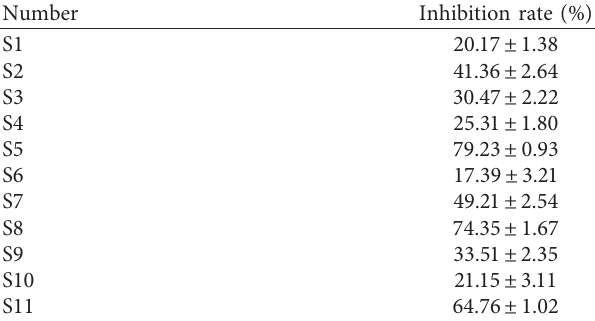
Figure 4: OPLS-DA analysis of 11 batches of AMR. (a) OPLS-DA scatter plot. (b) VIP values. (c) Load scatter plot. Table 6: Inhibition of the AMR from different producing areas on tyrosinase